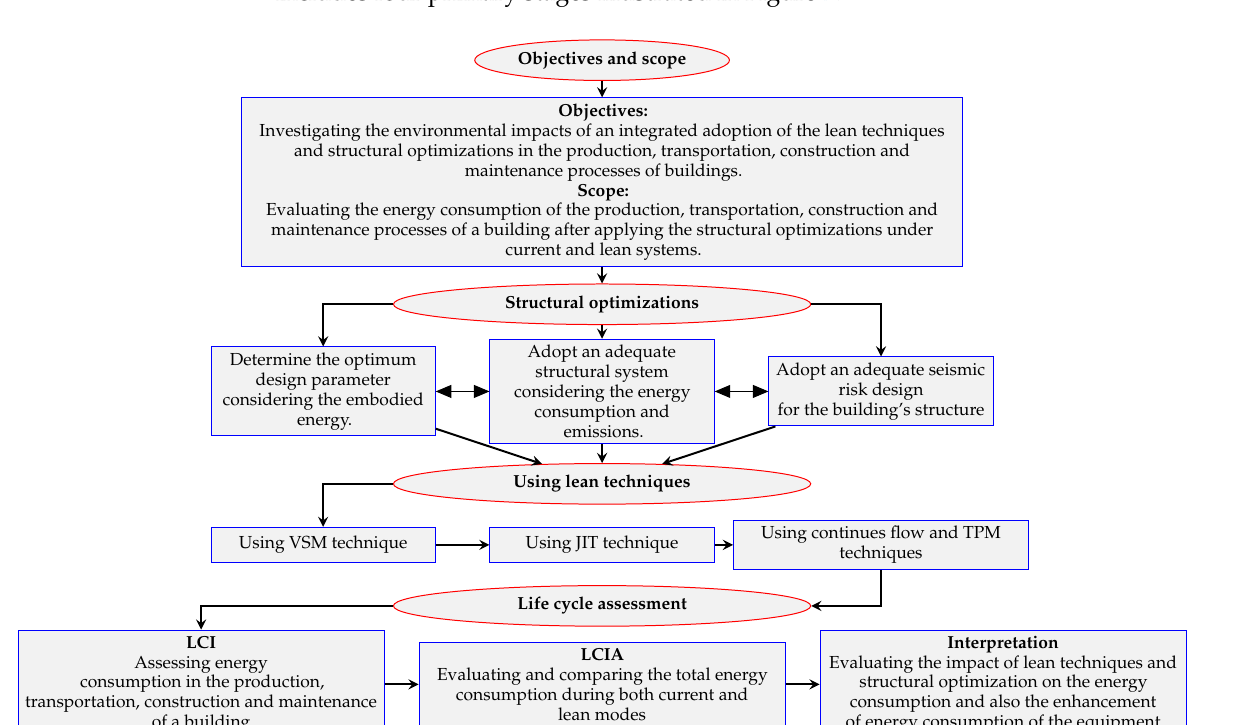
Figure 7. Proposed construction processes algorithm to obtain an optimum environmental